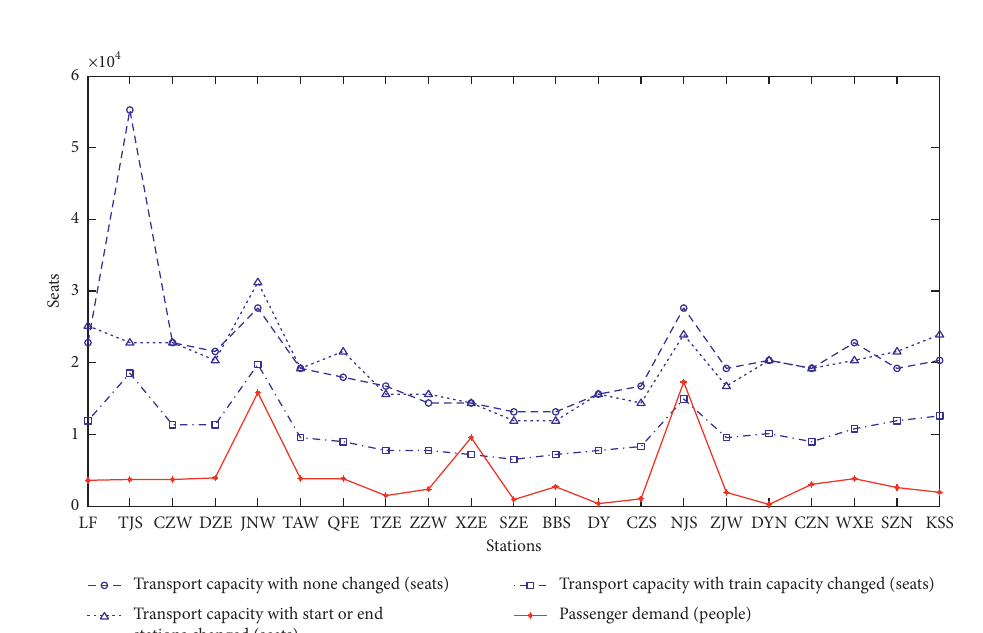
Figure 7: Comparison between transport demand and capacity of sensitivity analysis.